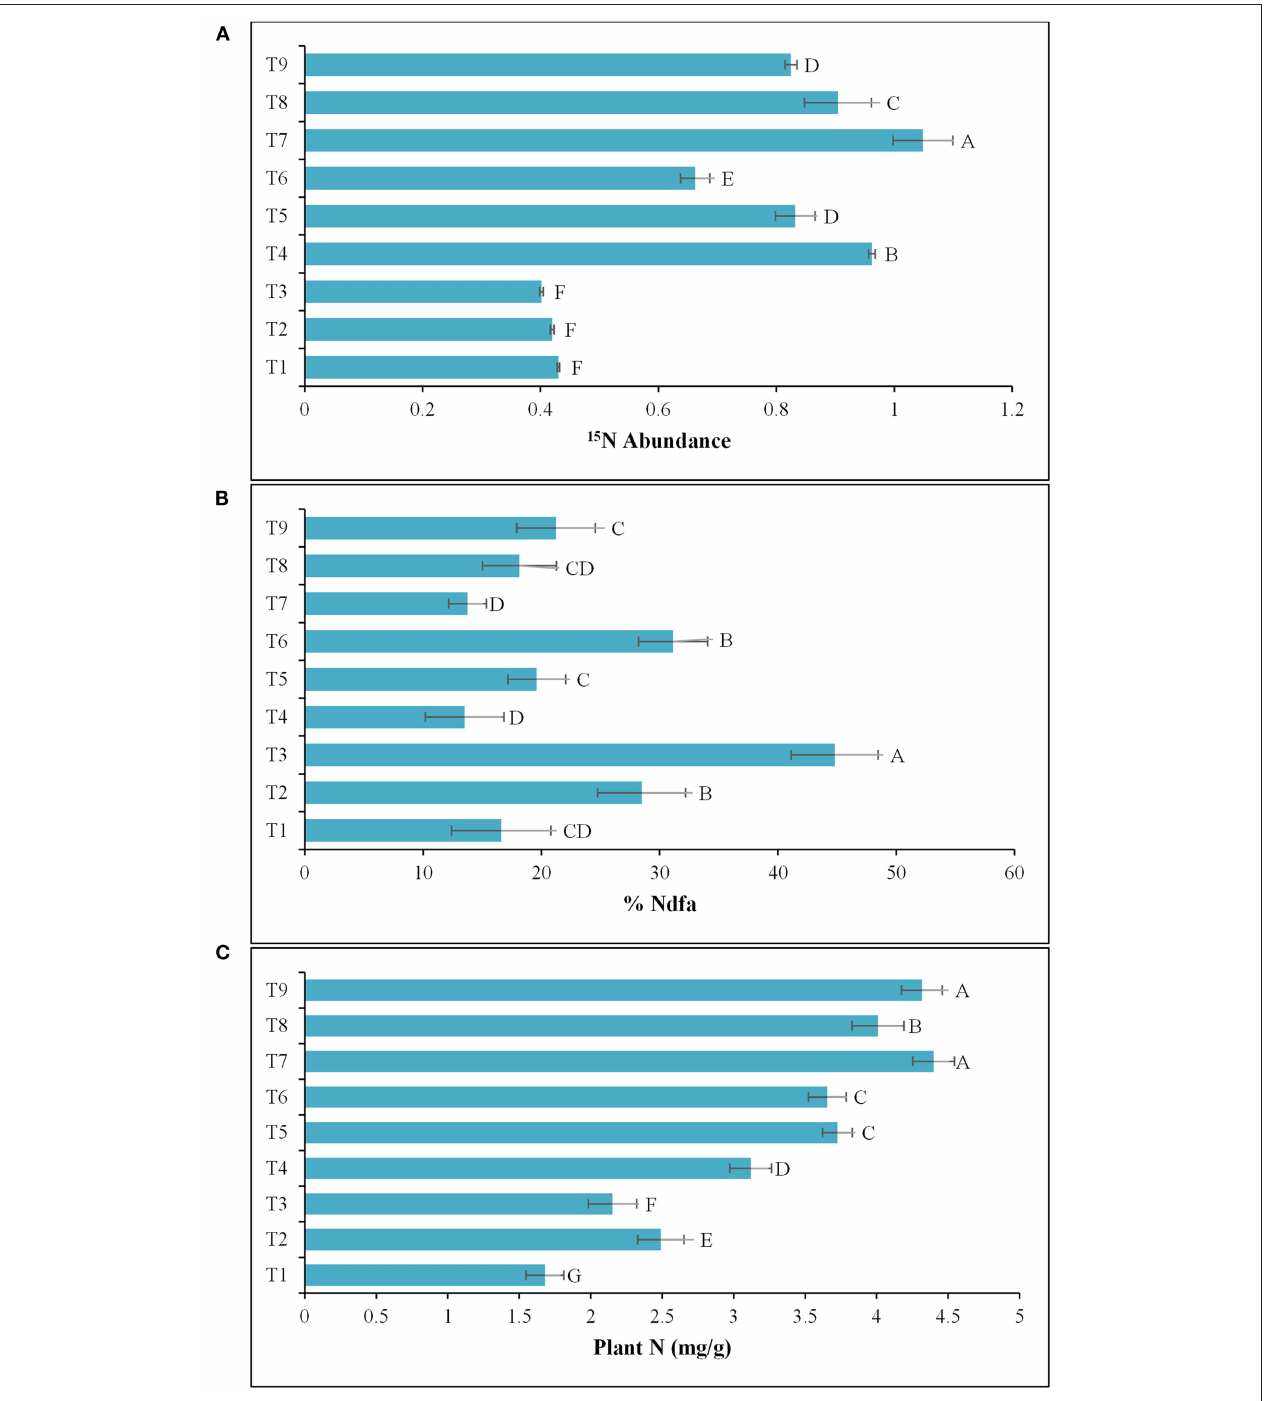
FIGURE 6 | Inoculation response of Azospirillum spp. strains TN03 and TN09 on root and shoot: (A) 15 N Abundance; (B) %Ndfa; and (C) Plant N. T 1 = Un-inoculated + 15 N 0 (-ve control treatment), T 2 = Inoculated with strain TN03 + 15 N 0 , T 3 = Inoculated with strain TN09 + 15 N 0 , T 4 = Un-inoculated + 15 N 1 / 2 ( + ve control treatment), T 5 = Inoculated with strain TN03 + 15 N 1 / 2 , T 6 = Inoculated with strain TN09 + 15 N 1 / 2 , T 7 = Un-inoculated + 15 N F ( ++ ve control treatment), T 8 = Inoculated with strain TN03 + 15 N F , and T 9 = Inoculated with strain TN09 + 15 N F ; Letters A, B, C, and D represent significant difference between means of all these treatments. Values are mean ± Standard Deviation. Number of biological replicates =